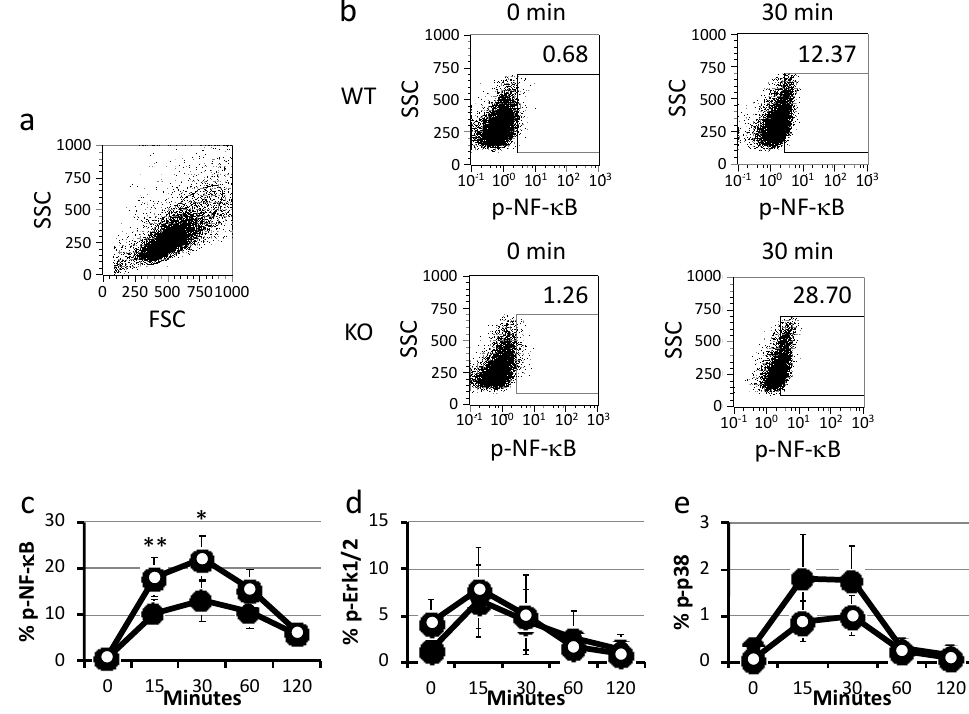
Figure 3. Phosphorylation of transcriptional factors in LPS-stimulated BMDCs. ( a ) Gating of BMDCs, which were induced from WT ( n = 9) and KO ( n = 9) mice. ( b ) Expression of phosphorylated NF-κB (Ser536) in LPS-stimulated BMDCs from WT and KO mice as revealed by flow-cytometry (see Materials and Methods). Data are representative of three independent experiments each involving six mice (WT n = 3, KO n = 3) ( c ) Proportions of phosphorylated NF-κB (Ser536) in BMDCs induced from WT (black circles) and KO (white circles) mice after LPS stimulation. ( d ) Data shown are the proportions of phosphorylated Erk1/2 (Thr202/Tyr204) in BMDCs from WT (black circles) and KO (white circles) mice after LPS stimulation. ( e ) Proportions of phosphorylated p-38 (pT180/pY182) in BMDCs from WT (black circles) and KO (white circles) mice after LPS stimulation. Data are collected the data of two independent experiments each involving six mice (WT n = 3, KO n =3) analyzed by two-way ANOVA with Bonferroni post hoc test. * p < 0.05, ** p <